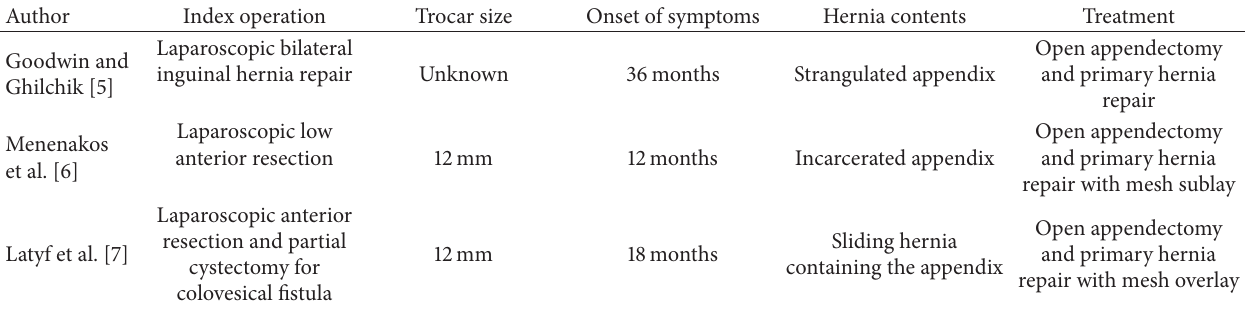
Table 1: Previous case reports describing trocar site hernias containing the appendix with subsequent